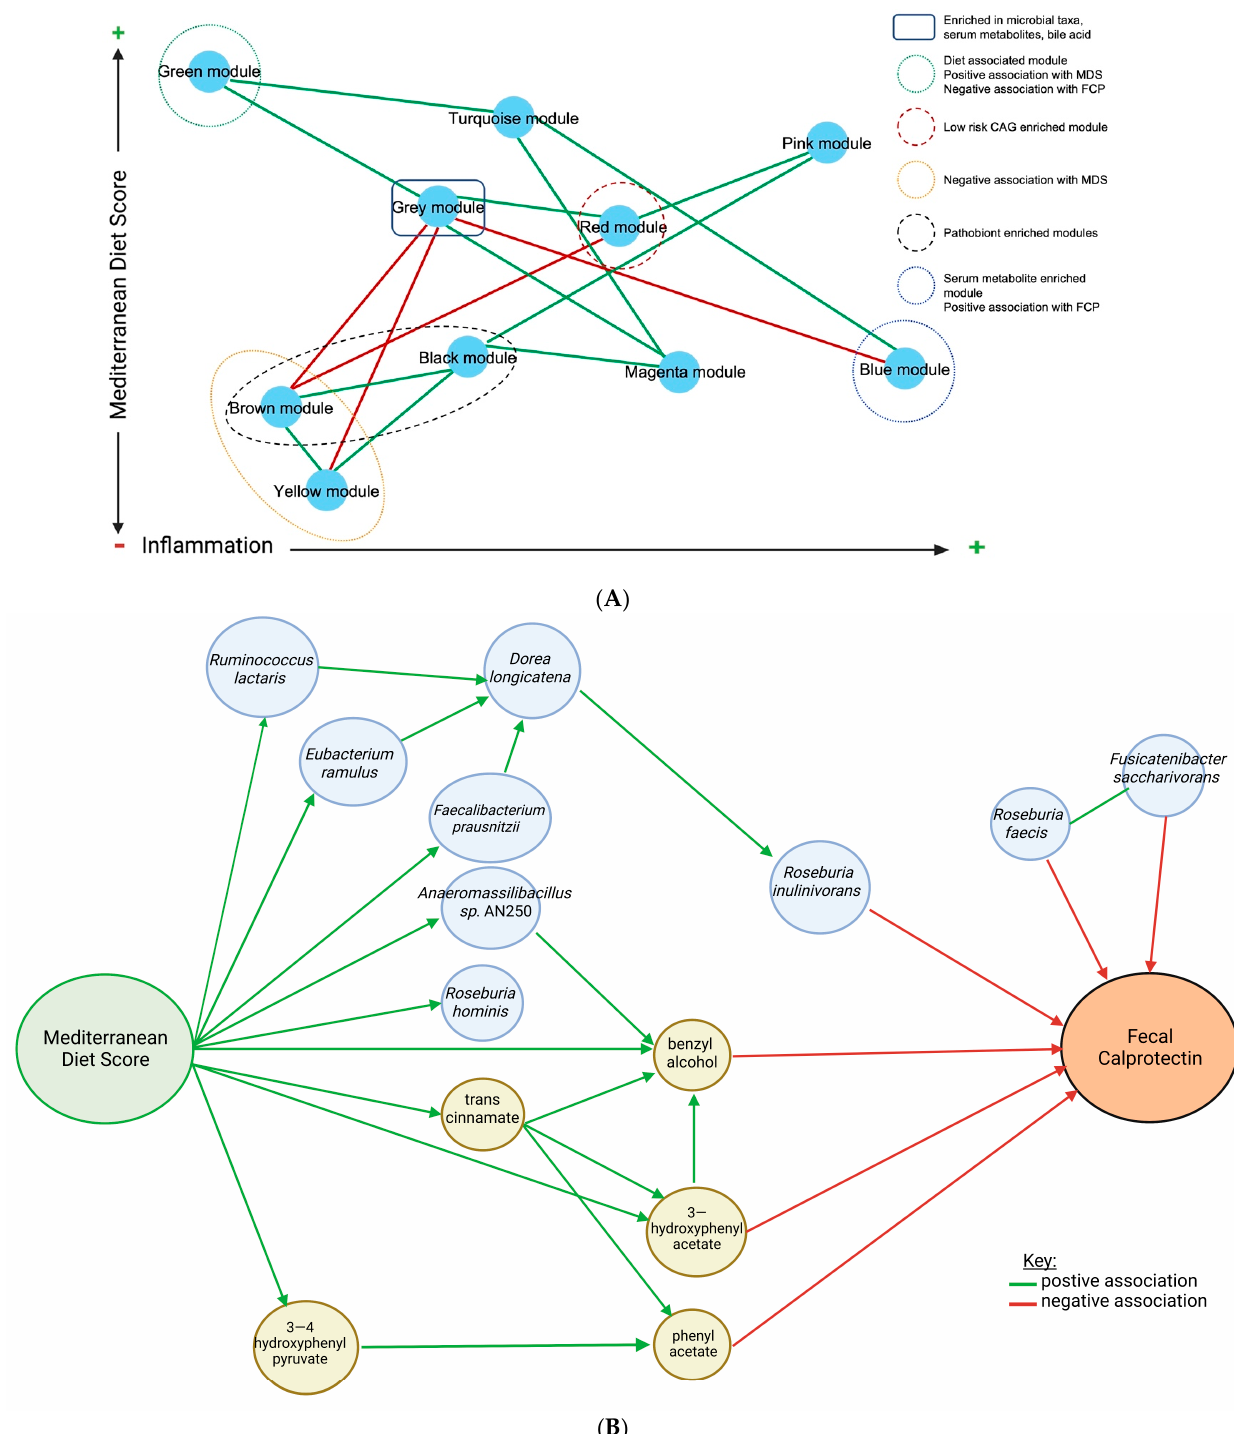
Figure 7. Inter-module association analysis. ( A ) Stepwise association pattern linking high adherence to the Mediterranean diet and fecal calprotectin mediated by microbiome-dominated modules. ( B ) Analysis of the sub-network amongst the select features from the grey module indicates specific microbiome and metabolite features that act as mediators in the relationship between fecal calpro- tectin and the Mediterranean diet score. Abbreviations: MDS, Mediterranean diet score, FCP, fecal calprotectin. Created with BioRender.com (accessed on 5 January